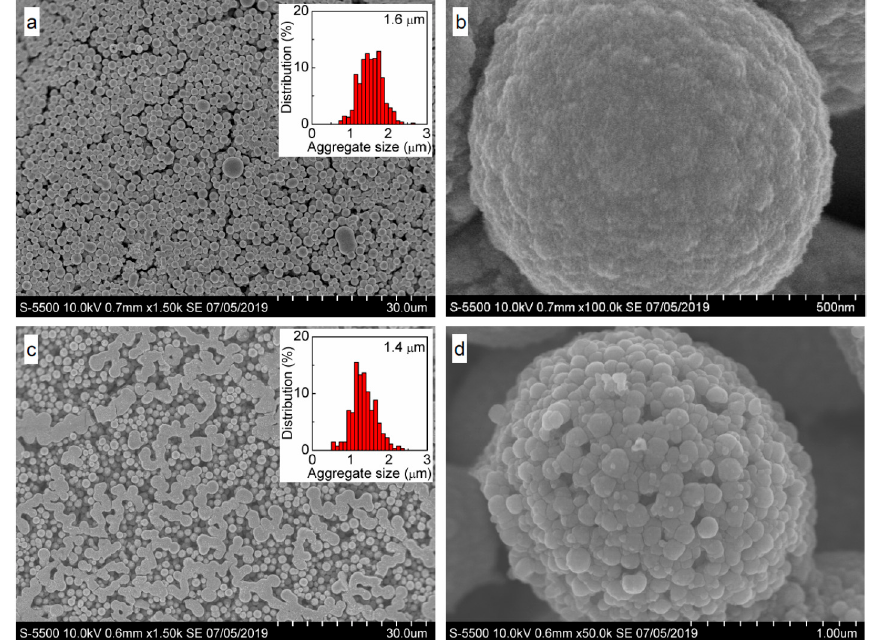
Figure 7. SEM images and particle size distribution of samples prepared via conditioning of deposited Carey Lea particles in 1 mM H 2 PtCl 6 for 20 min ( a , b ), 0.33 mM H 2 PdCl 4 solutions ( c , d ) for 40 min.